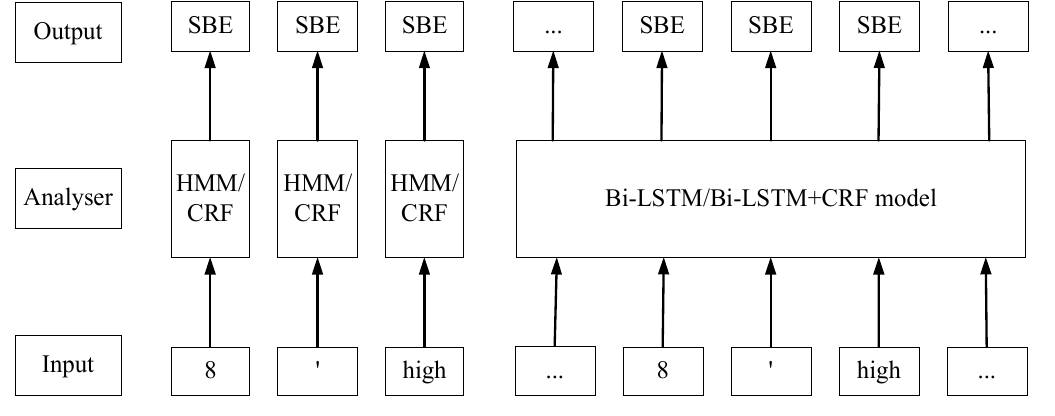
Figure 5. NER-based information extraction.